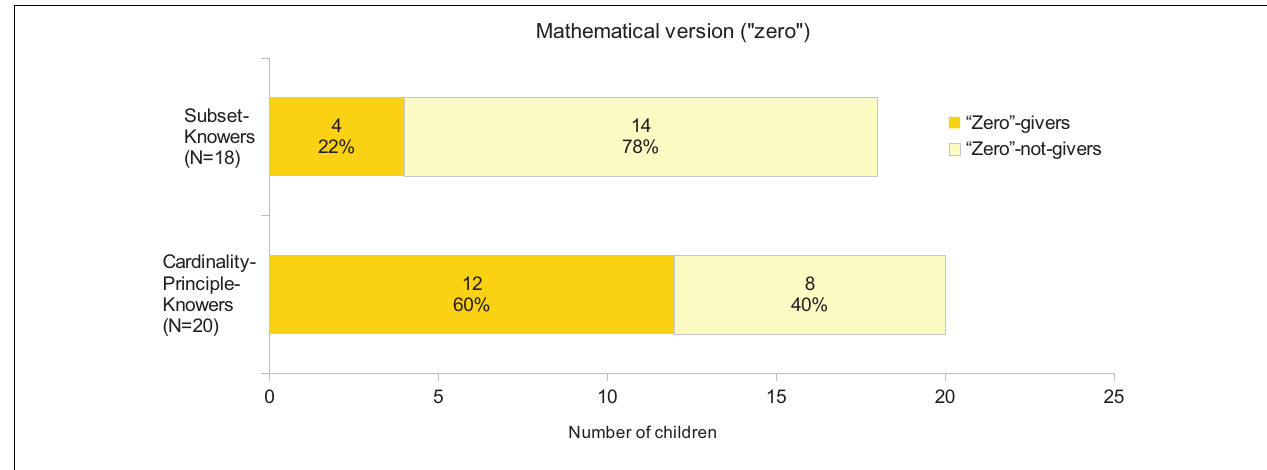
FIGURE 1 | Number of the children who understood the mathematical (“giving zero”) version of the zero task.